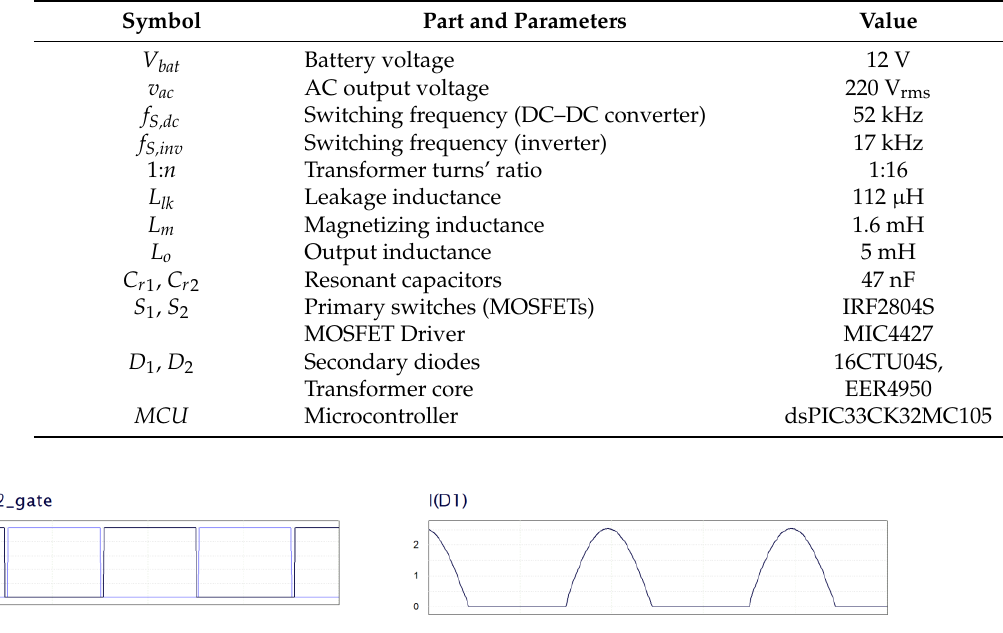
Table 1. Major components and parameters.